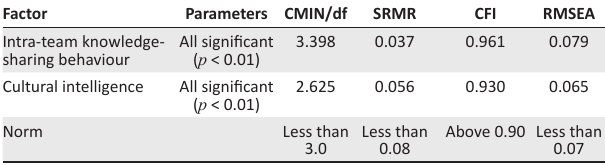
TABLE 3: Model fit indices of the confirmatory factor analysis. Factor